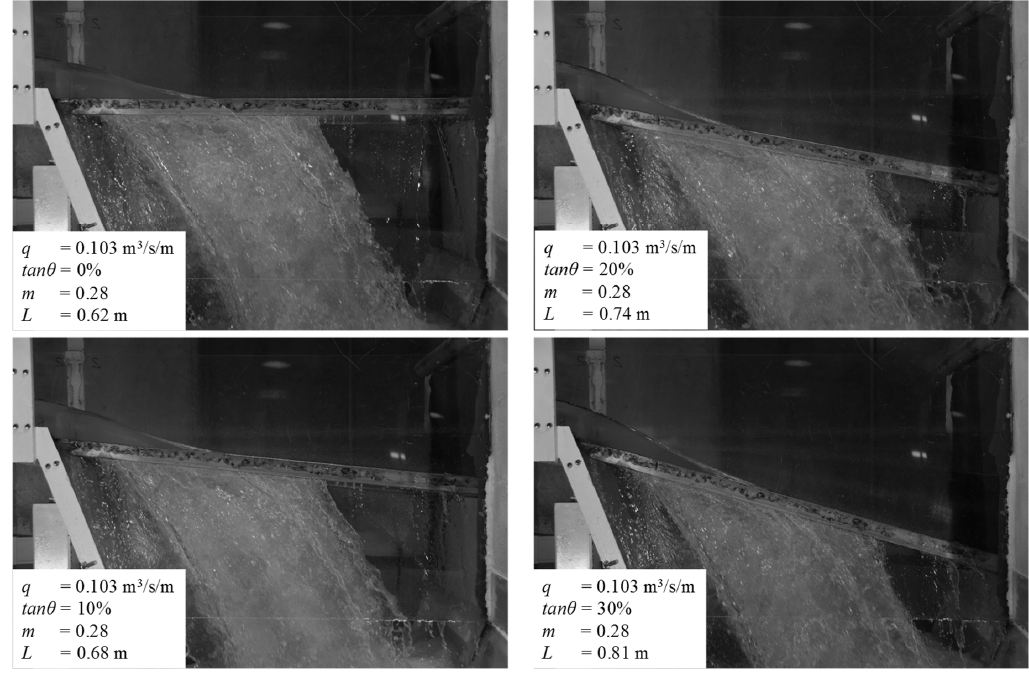
Figure 3. Wetted rack length for different flows and longitudinal slopes with racks made of circular bars and void ratio m = 0.28.